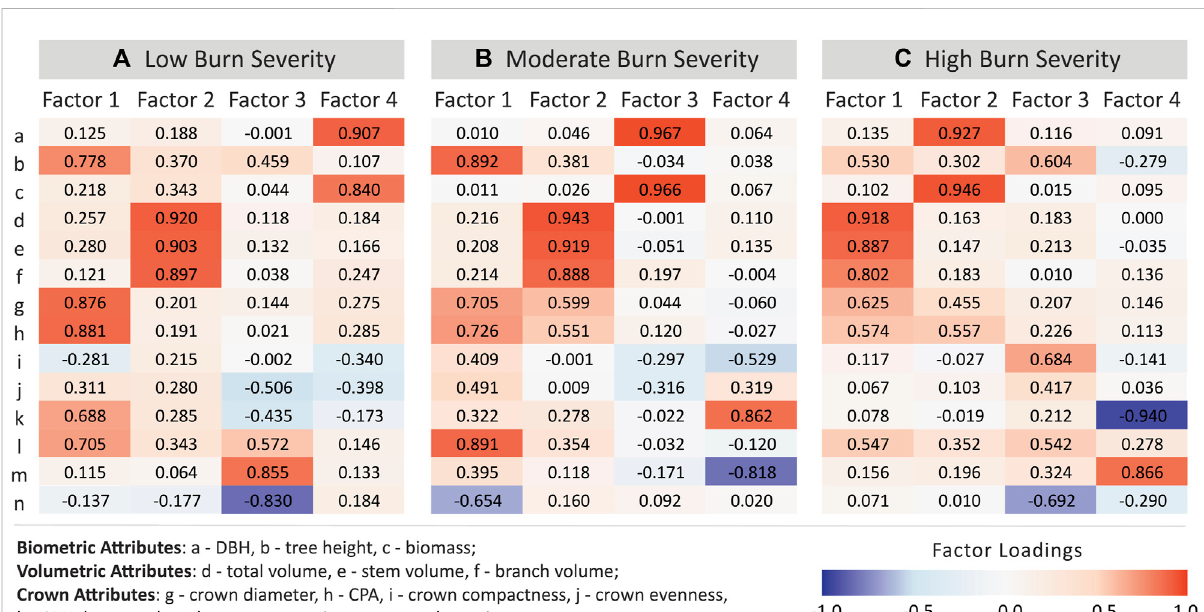
FIGURE 10 The loadings ofcommonfactors for post- fi re attributes in (A) low, (B) moderate, and (C) high plot-level burn-severities. The loadings represent the correlation coef fi cients between each post- fi re attribute and each factor. The factors are ordered in terms of their contribution to the data variance from high to